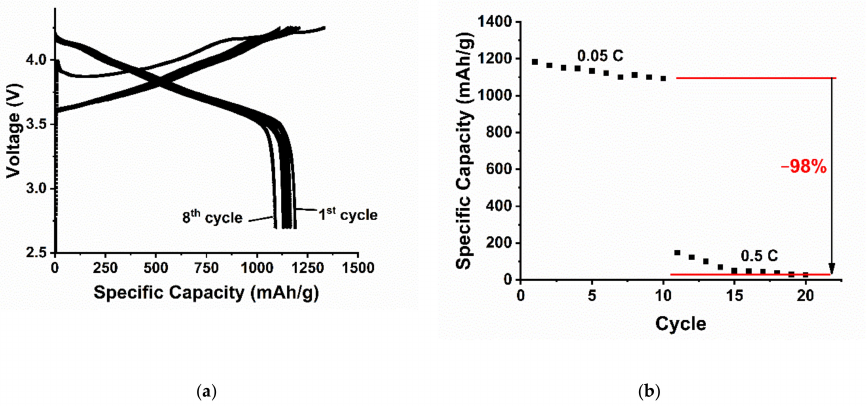
Figure 3. ( a ) Charge discharge curve and ( b ) ratability of SiO 2 as the LiNi 0.8 Co 0.15 Al 0.05 O 2 (NCA) battery anode.